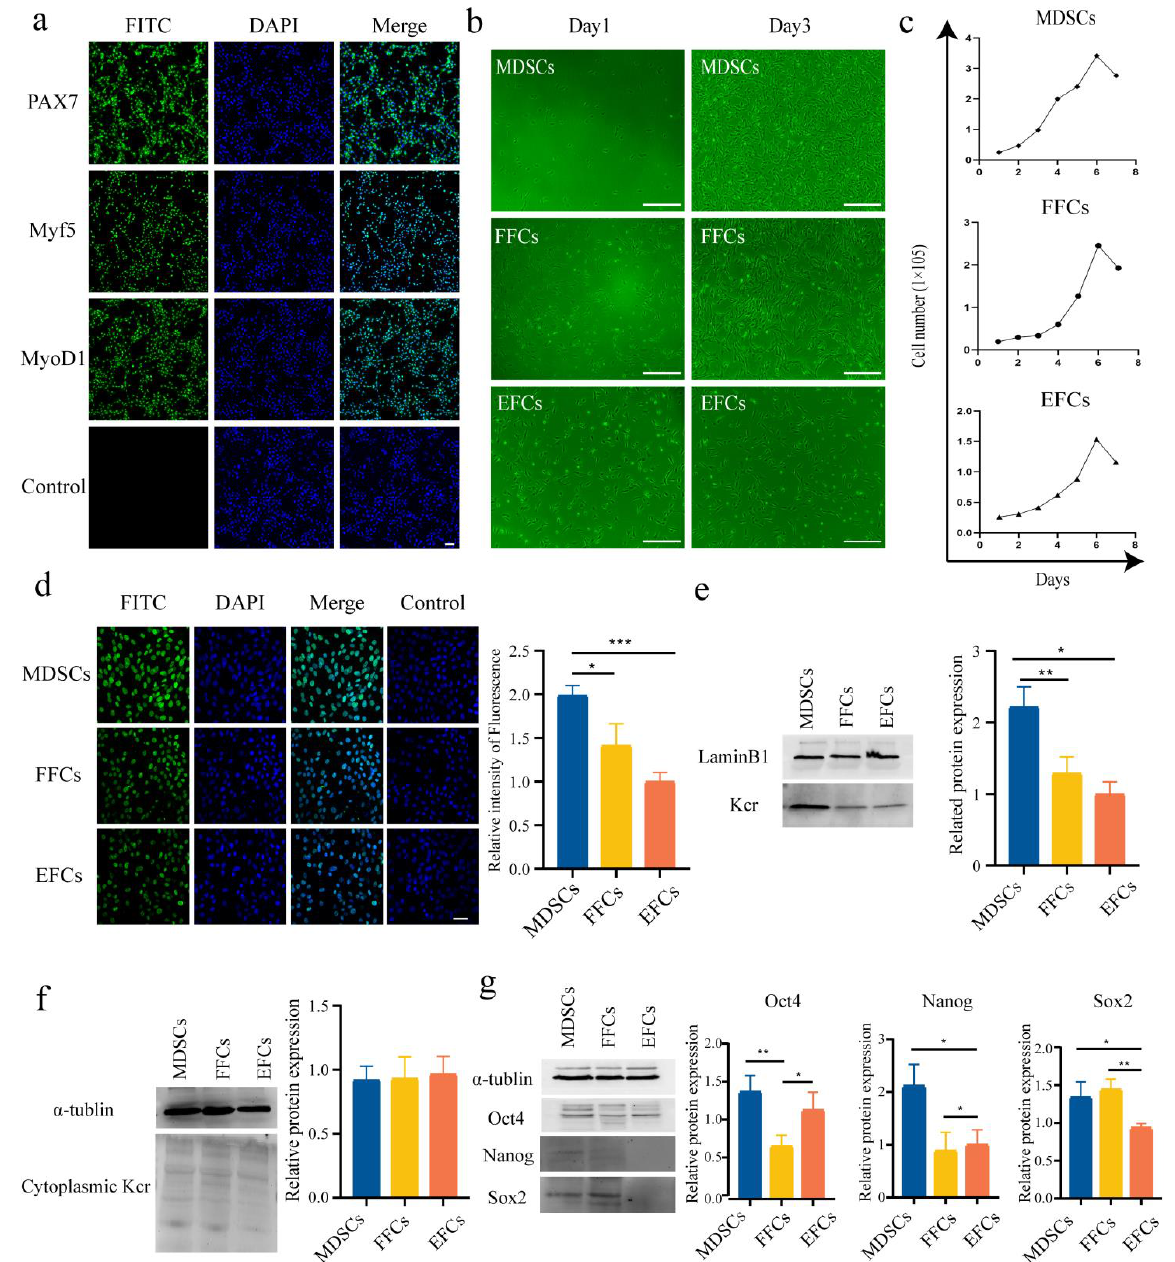
Figure 1. Preparation and characterization of three types of somatic cells. ( a ) The surface markers PAX7 , Myf5 , and MyoD1 of MDSCs were evaluated by immunofluorescence. PBS was used instead of the primary antibody as a negative control; nuclei (blue), target proteins (green) (scale bar, 100 µm); muscle-derived satellite cells: MDSCs; fetal fibroblasts cells: FFCs: ear tip fibroblasts cells: EFCs. ( b ) Three types of cultured somatic cells photographed on day 1 and day 3 (Scale bar, 500 µm). ( c ) The growth curves of three types of somatic cells. ( d ) Kcr levels in three types of somatic cells were examined and quantified by immunofluorescence; the negative control was prepared using PBS instead of the primary antibody (scale bar, 50 µm); Kcr: lysine crotonylation. ( e ) Western blotting for levels of histone Kcr in three types of somatic cells. Image J was used to quantify grey value. ( f ) Kcr level was examined by Western blot in cytoplasm, and a quantitative analysis of grey value was performed. ( g ) The expression of Oct4 , Sox2 , and Nanog was detected by Western blot, and the relative protein expression levels were quantified according to the protein grey value; * p < 0.05, ** p < 0.01, *** p < 0.001, no asterisk indicates no significant difference.